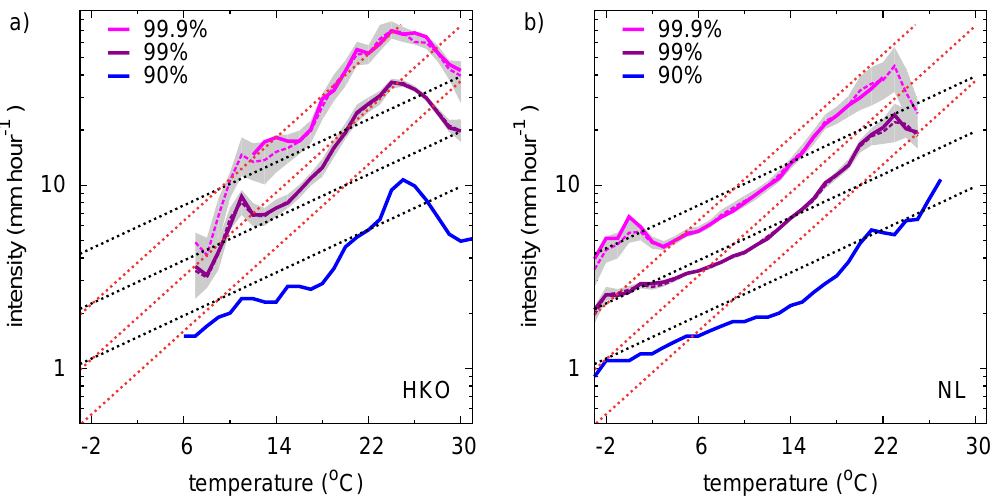
Fig. 1. Dependency of different percentiles of hourly precipitation extremes on daily mean temperature (left: HKO; right: NL). Stippled lines are estimates from the GPD fitting procedure, whereas solid lines are the percentiles computed from the raw data (in most cases these overlap). The grey shading denotes the 98% uncertainty range derived from the GPD fit. Red (black) stippled lines denote dependencies of 14% (7%) per degree. For comparison, these lines are identical in all plots; the distance between two lines is a factor 2 in intensity.